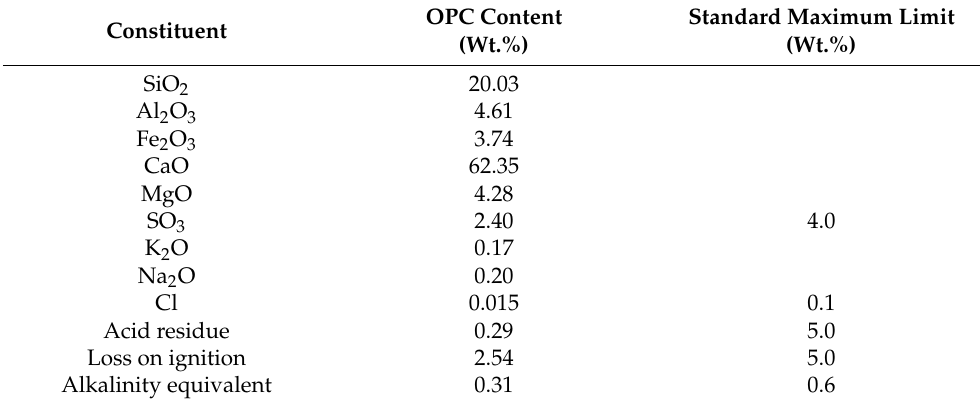
Table 2. Chemical composition of the study of ordinary Portland cement (OPC) compared to Saudi Standard SASO GSO 1914/2009 (E).